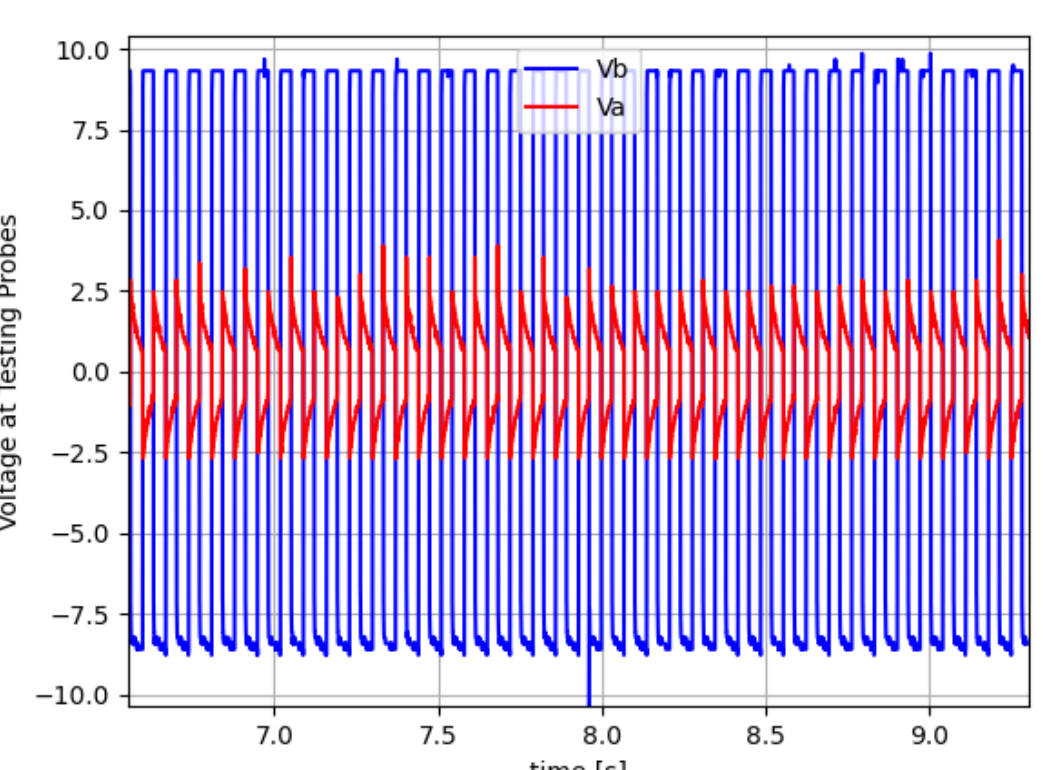
Figure 14. Experimental results for both signals, v a and v b : a zoom-in version of the previous